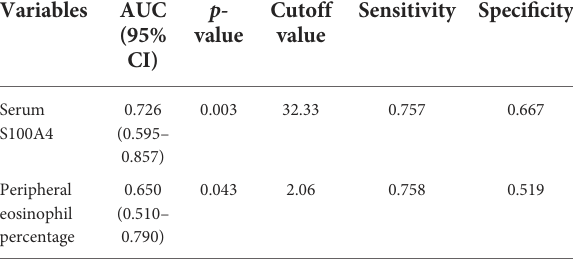
TABLE 4 ROC analysis results of different predictors for SCIT ef fi cacy.